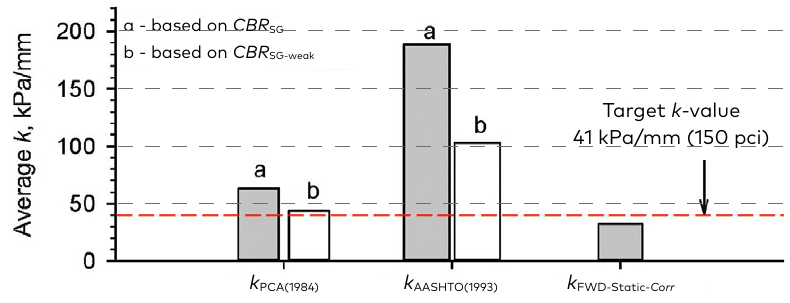
Figure 7. Bar chart comparing the design target k value with measured and estimated k values from field measurements